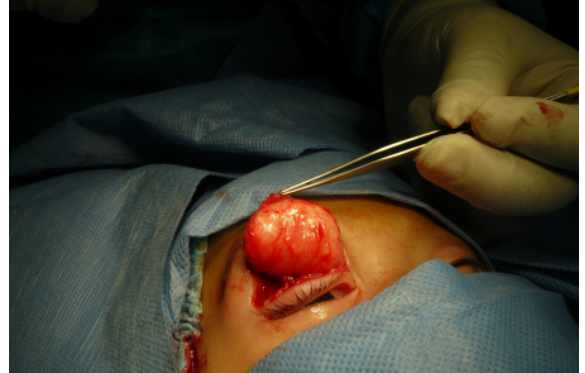
Figure 3: Peroperative photograph shows a yellowish-white soft tissue mass.